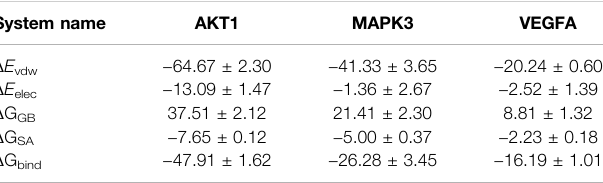
TABLE4| BindingfreeenergiesandenergycomponentspredictedbyMM/GBSA